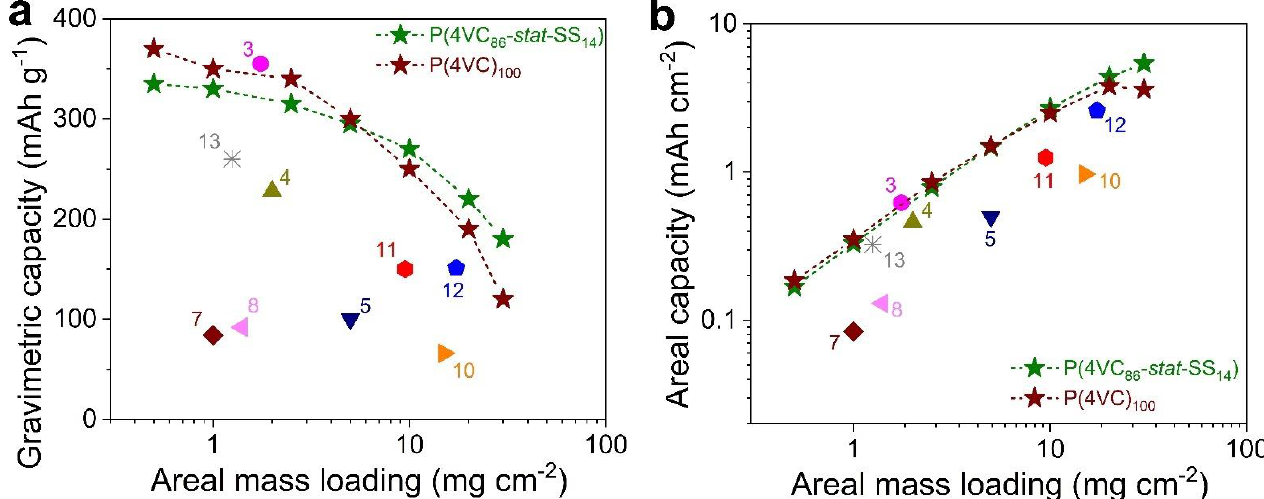
Figure 7. Comparing gravimetric ( a ) and areal capacity ( b ) of Zn||P(4VC) 100 and Zn||P(4VC 86 - stat -SS 14 ) cells with the state-of-the-art polymer electrodes in AZPBs (Table S1).